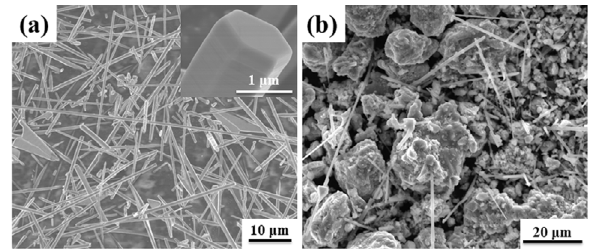
Fig. 2 SEM images of (a) well-dispersed SiC w with PEI at pH = 3 and (b) 10 wt% SiC w /Ti 3 SiC 2 mixture intentionally agglomerated at pH = 9.